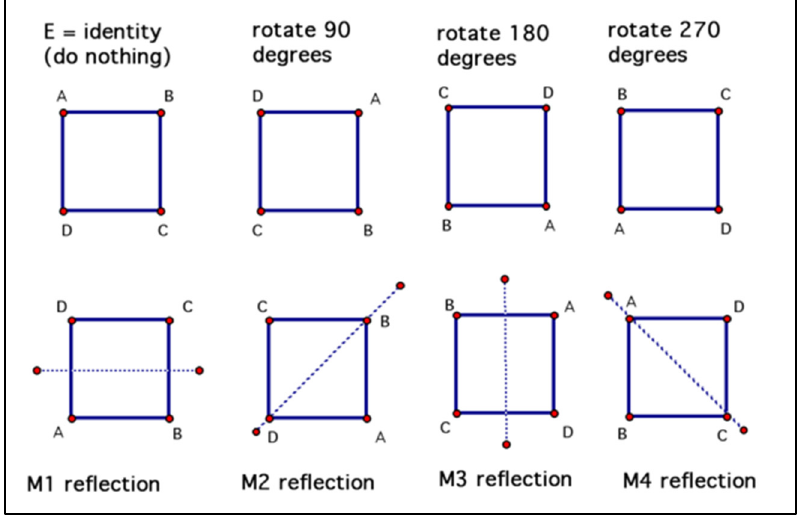
Figure 5. Diagram of selected geometric transformations. “M1 reflection” and “M3 reflection” refer to horizontal and vertical flipping, respectively. “M2 reflection” and “M4 reflection” refer to transposition.